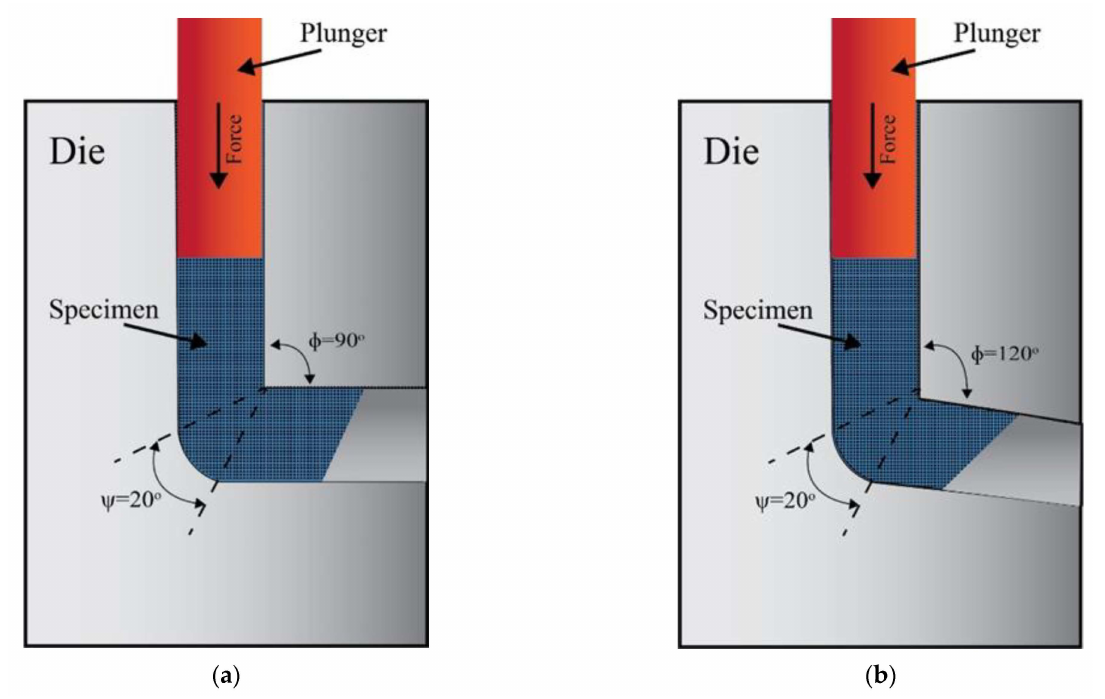
Figure 1. Schematic of the ECAP dies with internal channel angle of ( a ) 90 ◦ and ( b ) 120 ◦ . A, Bc, and C are the most prevalent ECAP route types [28,53]. Unlike route Bc, which rotates the sample by 90 degrees across its longitudinal axis after each pass, route A processes the sample in successive passes without rotating it [28,46,53]. After each pass along route C, the sample is rotated 180 degrees around the direction of extrusion [53,54]. Equation (1) illustrates how to determine the imposed equivalent strain ( ε eq ) using the number of ECAP passes (N), die channel angle ( φ ), and corner curvature angle ( Ψ )